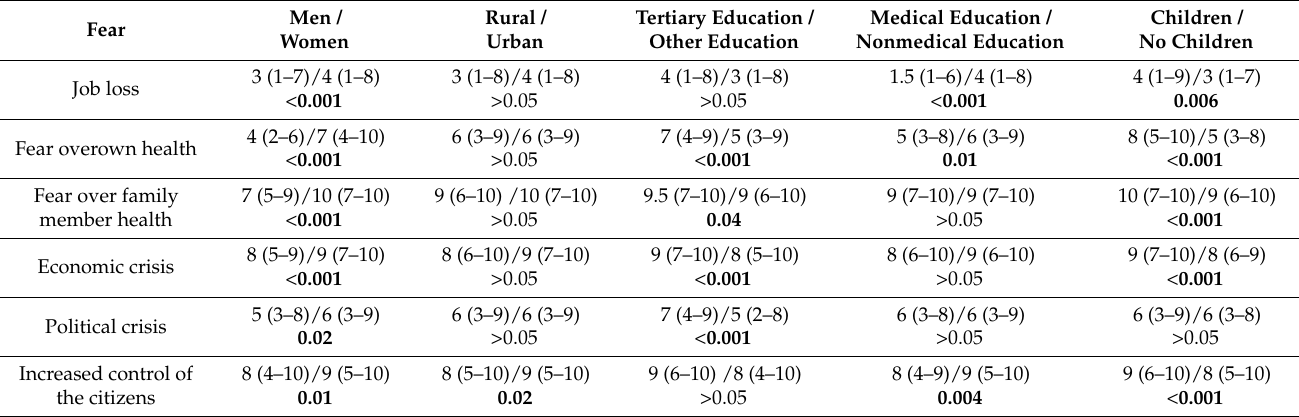
Table 3. The fears ((median (interquartile range)) related to the COVID-19 pandemic and its consequences in different subgroups of the studied population ( n = 1337), evaluated using a 10-point Likert-type scale. p -value indicating significant differences is given in bold (Mann–Whitney U-test).